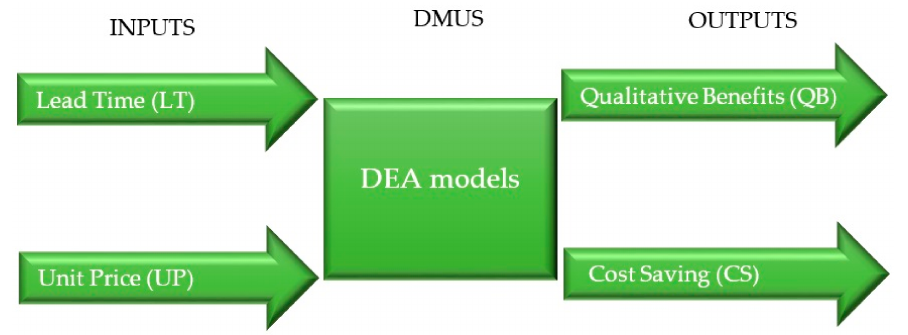
Figure 6. Inputs and Outputs of DEA